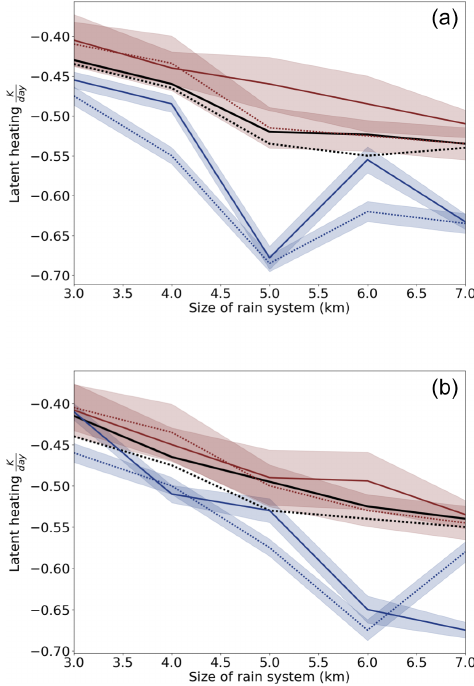
Figure A4. Figure 5 with ± standard error